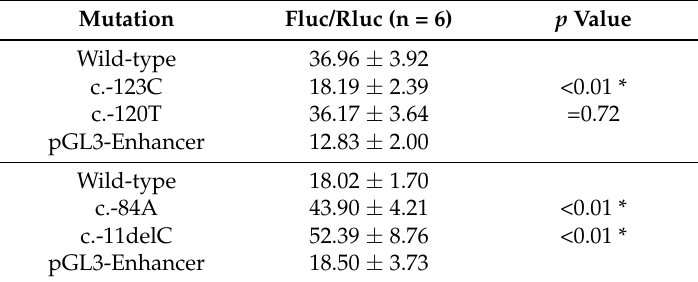
Table 3. Reporter gene activity assay of rare mutations the TBX1